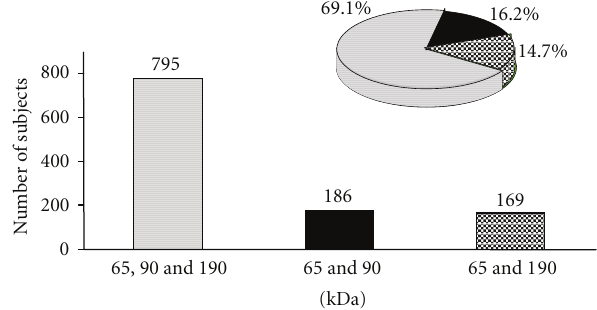
Figure 2: Distribution of ACE urinary isoforms and percentile of presence in subjects